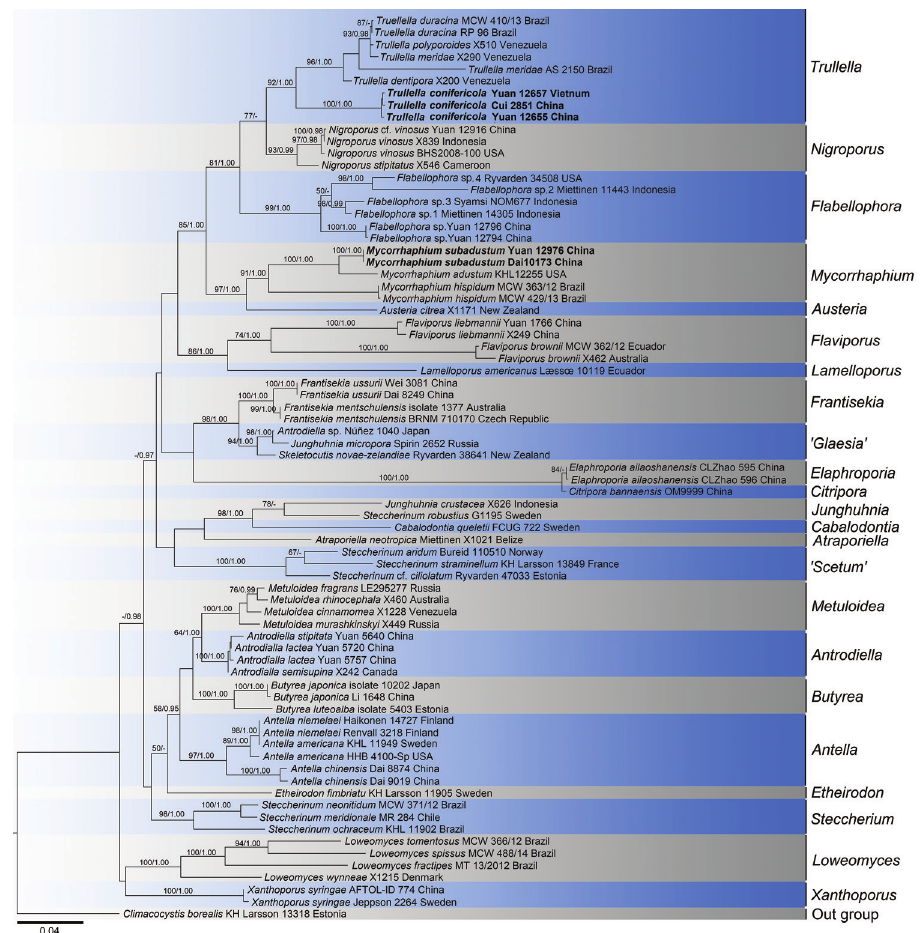
Figure 1. Maximum likelihood tree based on the combined ITS + nrLSU + tef1 sequence dataset illustrating the phylogeny of Mycorrhaphium subadustum and Trullella conifericola and related taxa in Steccherinaceae. The new species are in bold. Branches are labelled with maximum likelihood bootstrap higher than 50% and Bayesian posterior probabilities more than